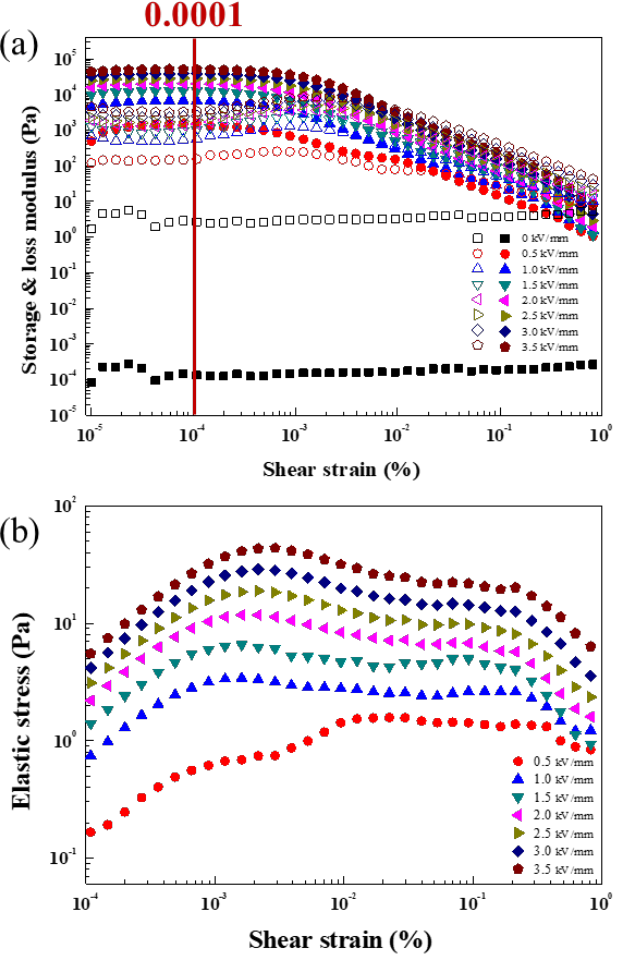
Figure 8. ( a ) Strain amplitude sweep measurement (closed: G′, open: G″) as a function of 𝛾 of ZnFe 2 O 4 /PMA based ER fluid and ( b ) τ’ as a function of 𝛾 obtained using G’ .